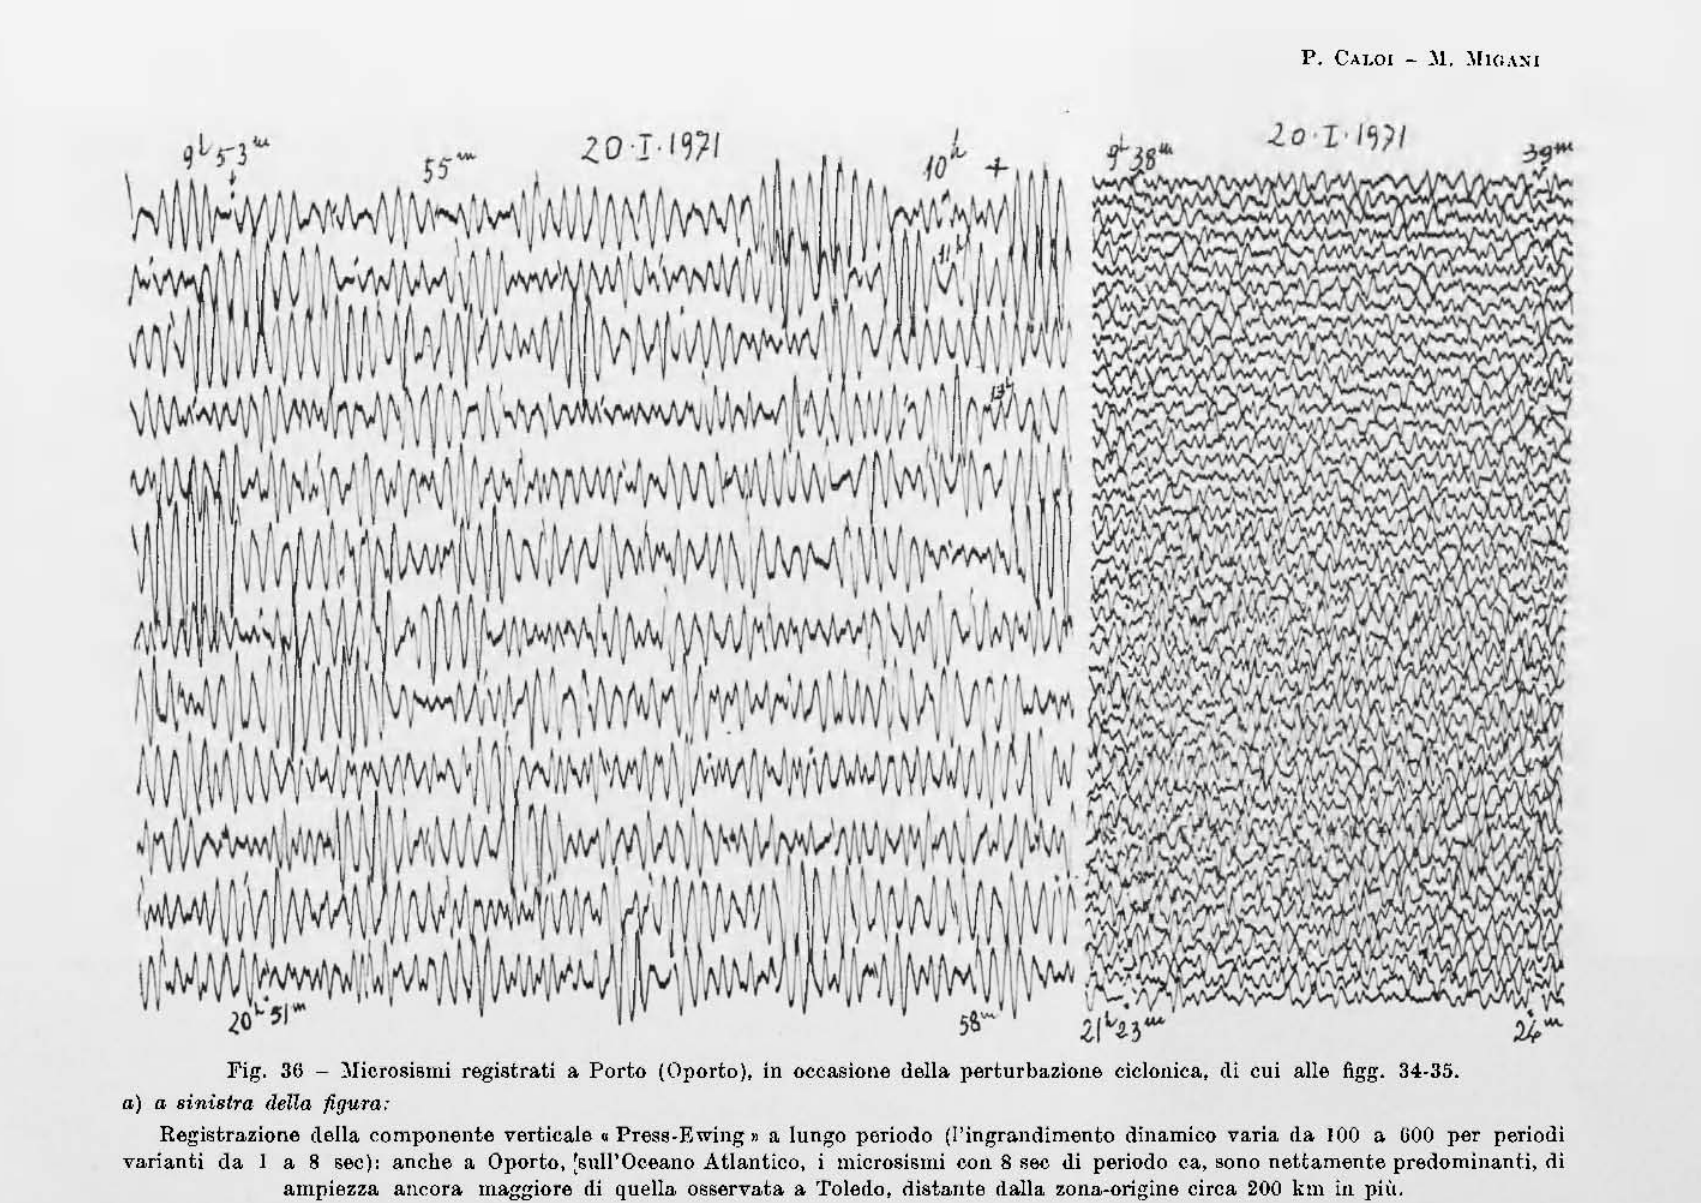
Fig. 36 - l\ficroseisms recor(led at Oporto (Portugal) during the cyclonic perturbation indicated in ftgs. 34 and 3ii. a) 011. the left of the